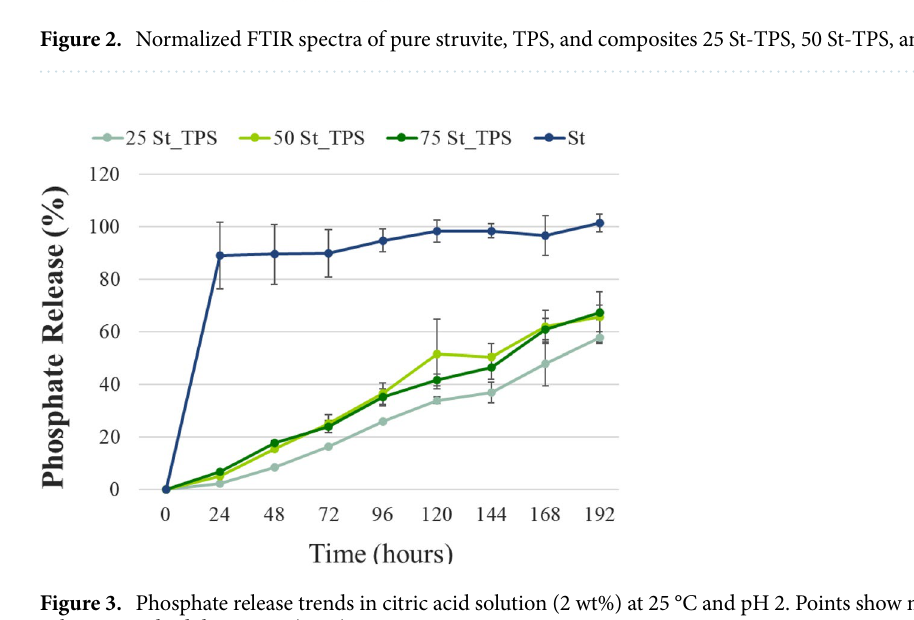
Figure 3. Phosphate release trends in citric acid solution (2 wt%) at 25 °C and pH 2. Points show mean values ± standard deviations (n =